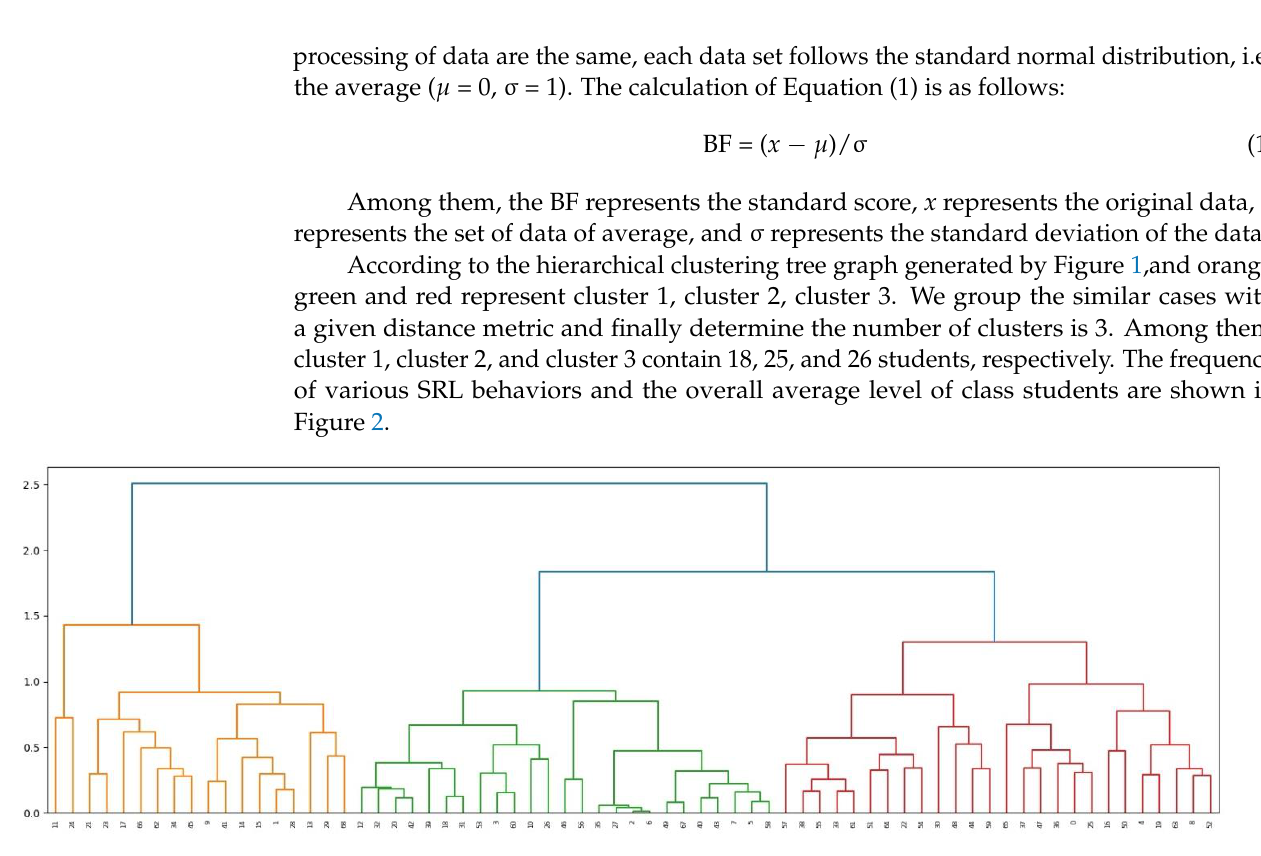
Figure 1. Dendrogram of the clustering result.